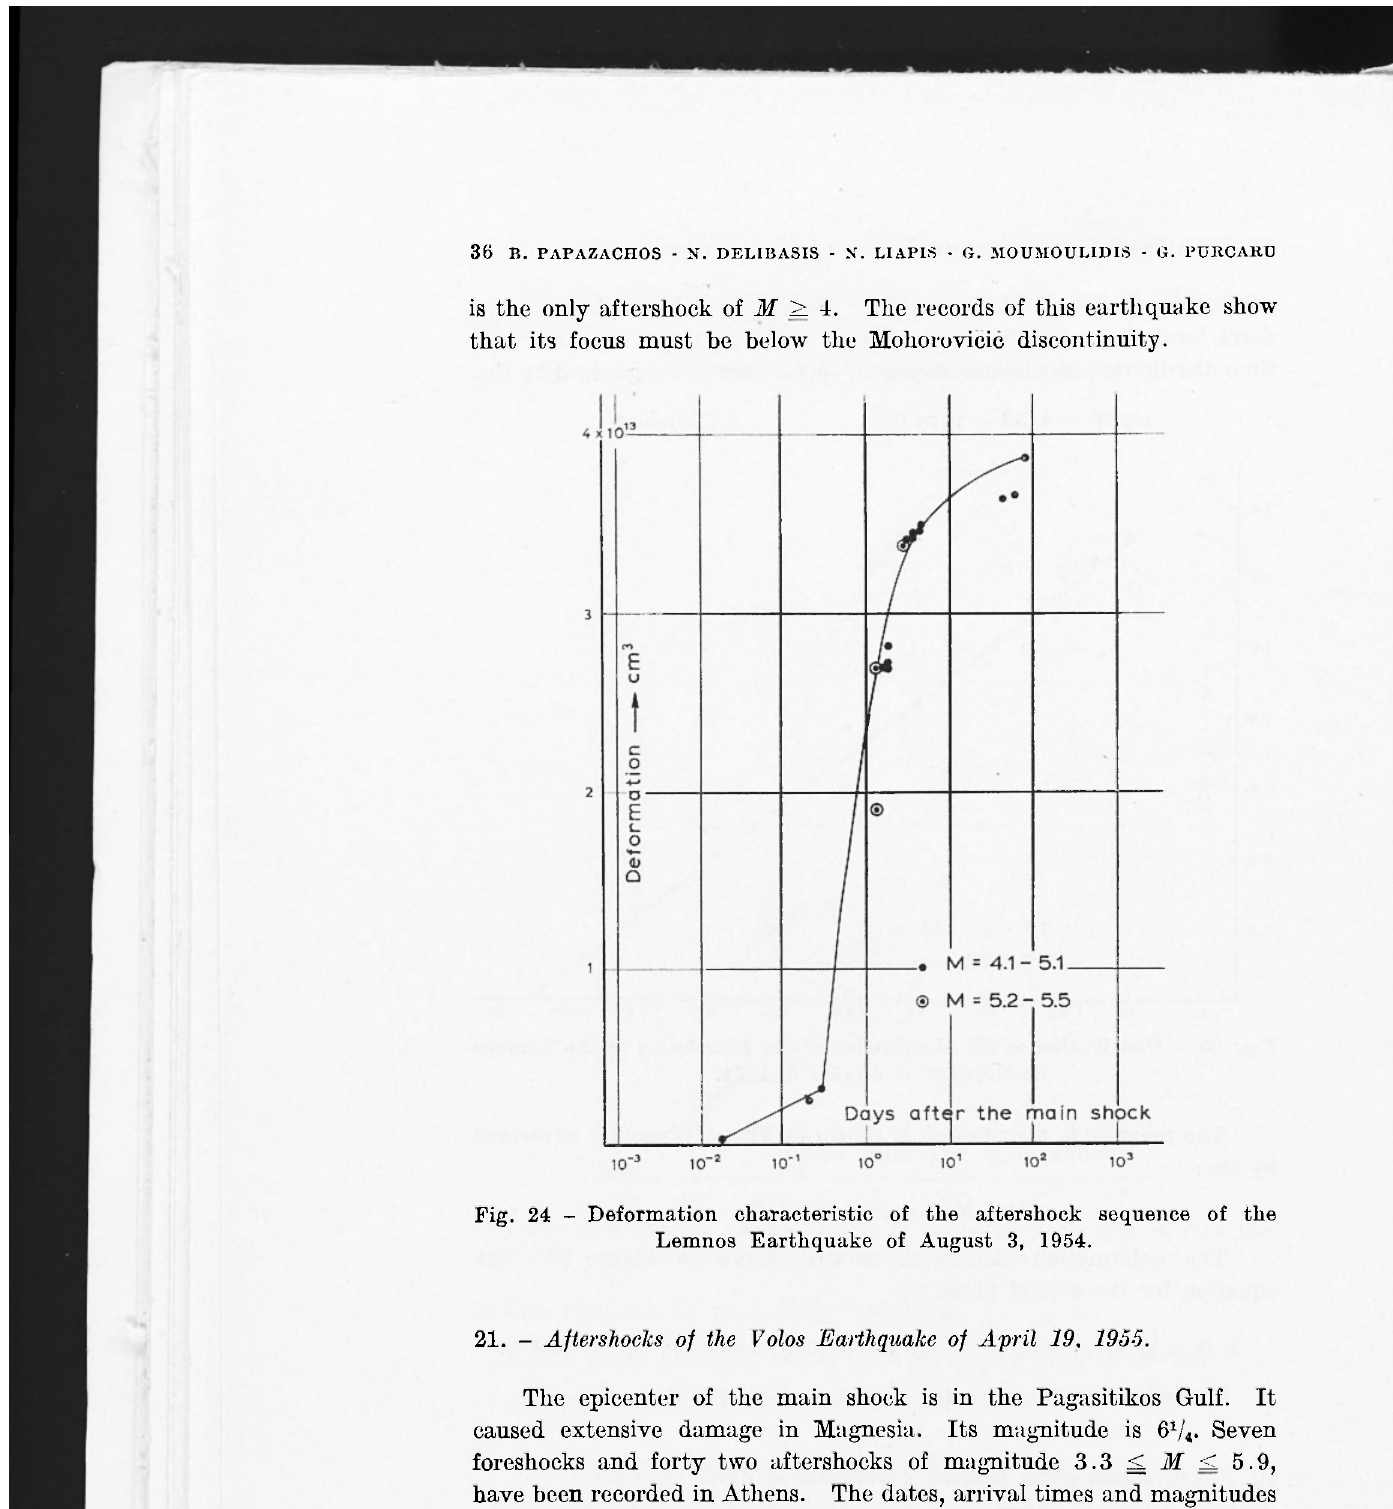
21. - Aftershocks of the Volos Earthquake of April 19.